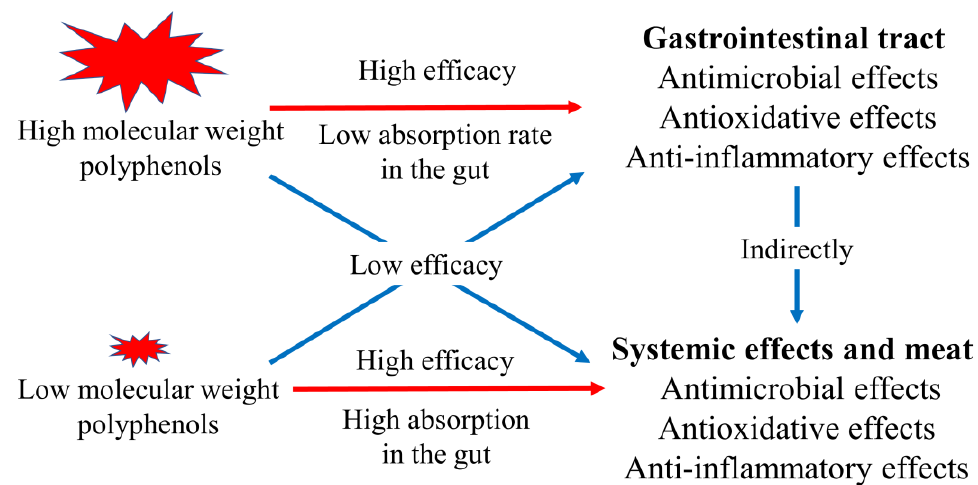
Figure 1. Proposed effects of low- and high- accumulating mycotoxins on the meat quality of broiler chickens. Low-accumulating mycotoxins negatively affect the gut health and gut microbiota of